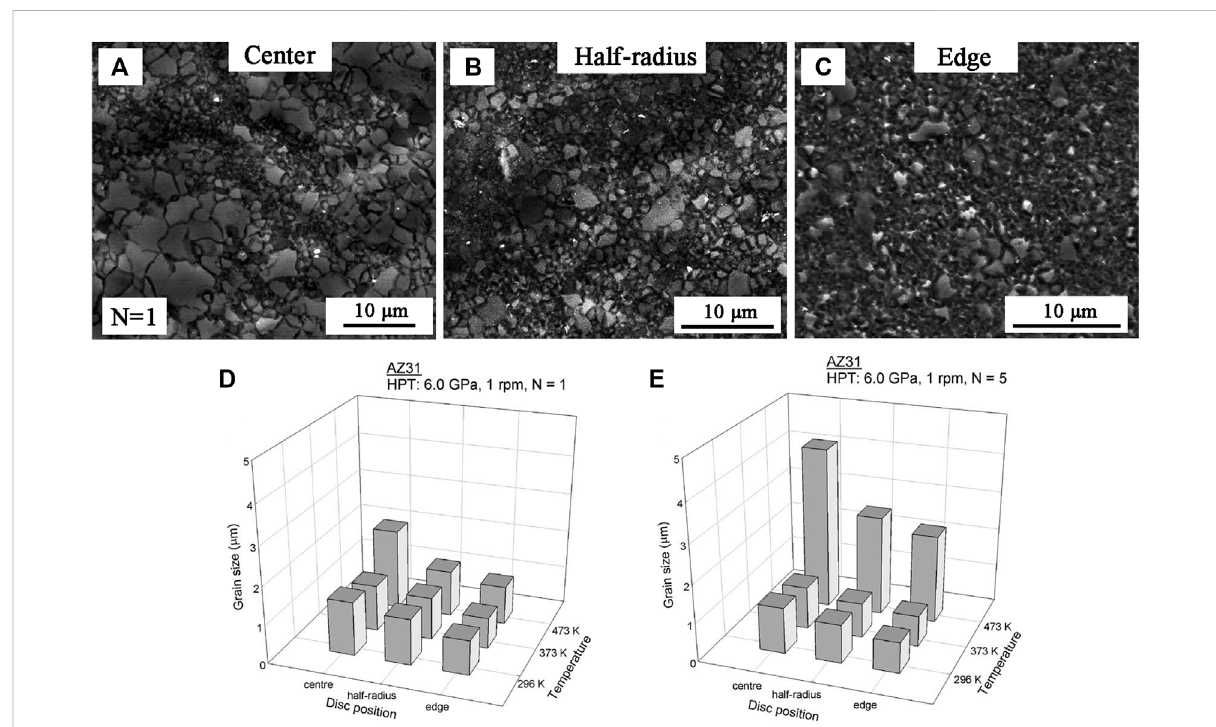
FIGURE 3 The grain re fi nement of HPTed AZ31 alloys at (A) the center, (B) the half-radius, (C) the edge position, and the grain size distribution of different temperatures through (D) 1 turn and (E) 5 turns (Huang et al.,